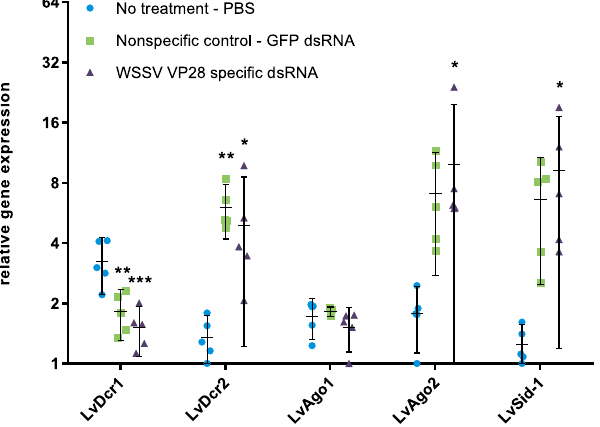
Figure 6. 48 hours after dsRNA injection, relative gene expression on a panel of host genes associated with small RNA silencing was carried out by RT-qPCR assays. Relative gene expression was measured through fold variation from the lowest obtained normalized expression value observed in all samples. One-way ANOVA with Dunnett’s multiple comparisons test was performed individually for each gene comparing the two dsRNA treatment groups to the no treatment (PBS) group. Significant variation at α = 0.05 is indicated and error bars indicate the 95% CI around the